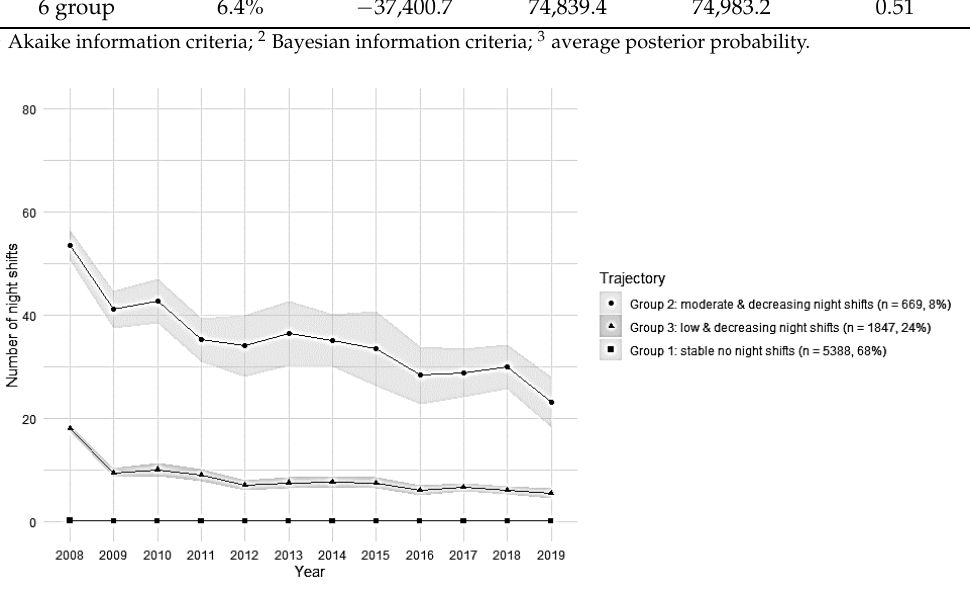
Table 1. The goodness of fit of group-based trajectory analysis for sample 1.